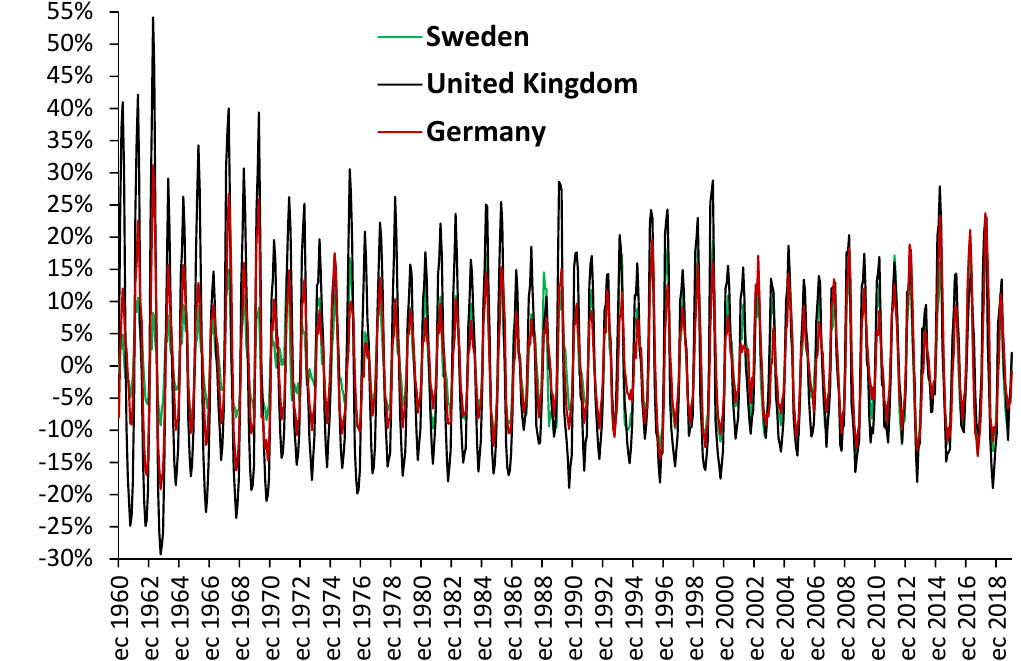
Figure 7. Rolling 3-year average of EWM in Singapore (1960 to 2020).